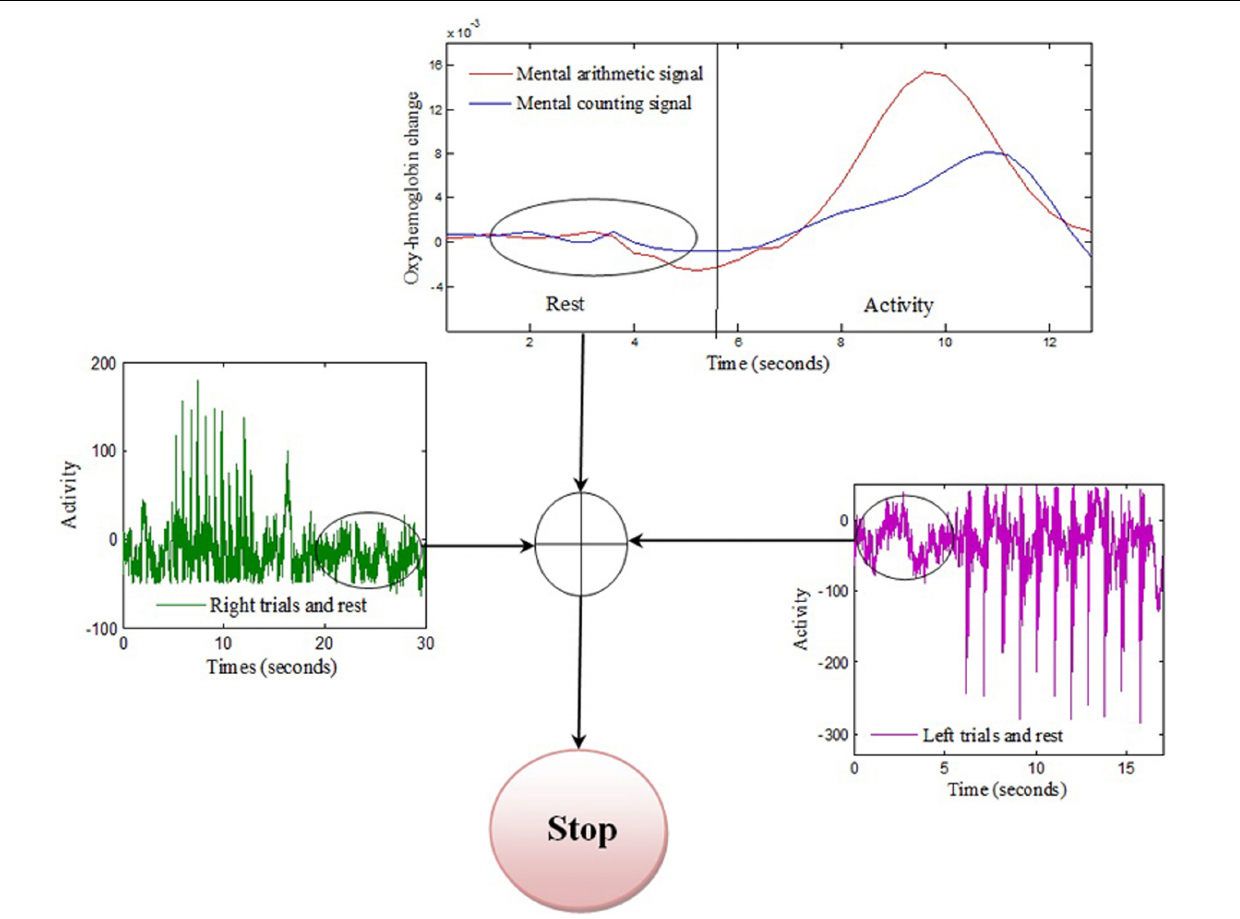
FIGURE 5 | Stop condition: Common rest state of the three signals is selected as stop command. The “Stop” command can only be generated if absolute rest is detected from three brain regions.